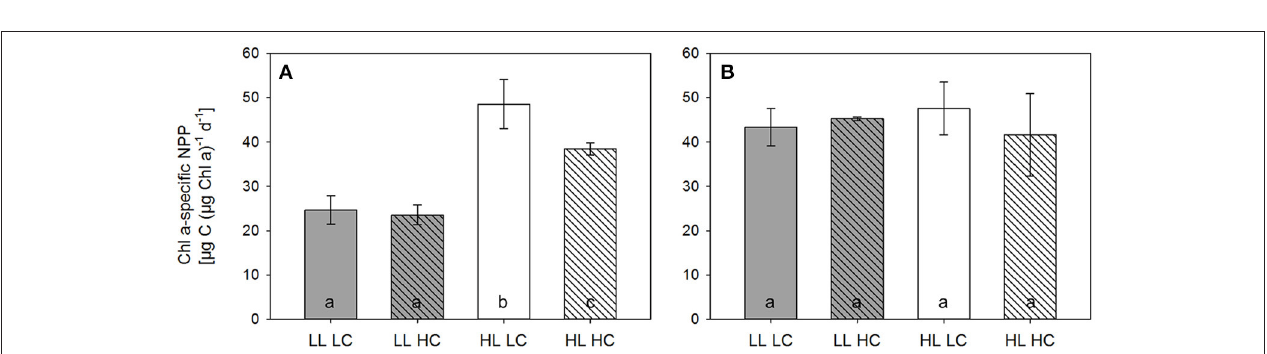
FIGURE 4 | POC-normalized picoeukaryote counts measured in LL (gray bars) and HL incubators (white bars) under LC (open bars) and HC (hatched bars) over 24 h before the dilution (A) and the final sampling (B) of the experiment ( n = 3, errors bars indicate 1 s.d.). Different letters indicate significant differences between treatments.